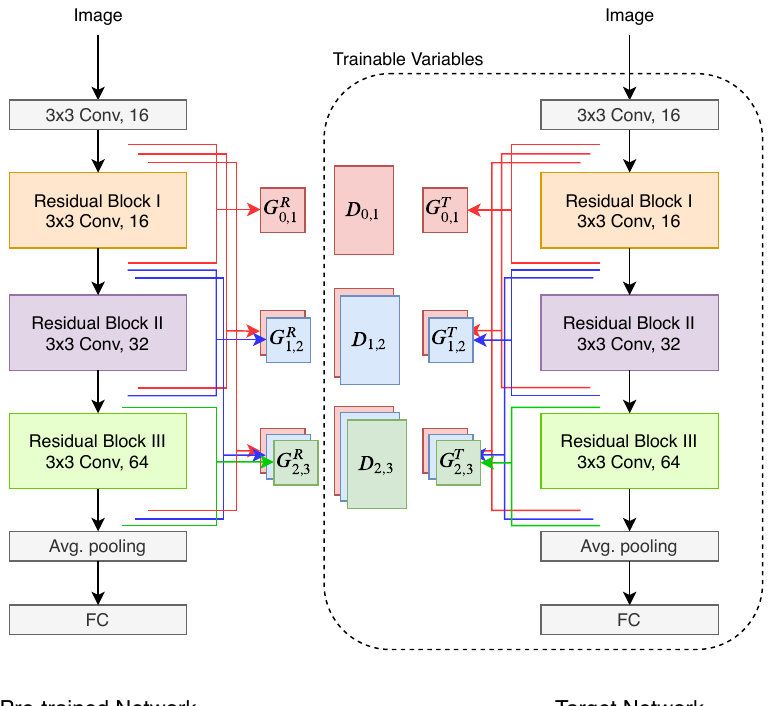
Figure 2. Adversarial concurrent knowledge transfer structure using the layer-wise dense flow. In this figure, G R , G T , and D i , j refer to the FSP matrix of pre-trained ResNet, the FSP matrix of target i , j i , j ResNet, and the discriminator, respectively. Only the variables in the dotted box marked “Trainable Variables” are used for